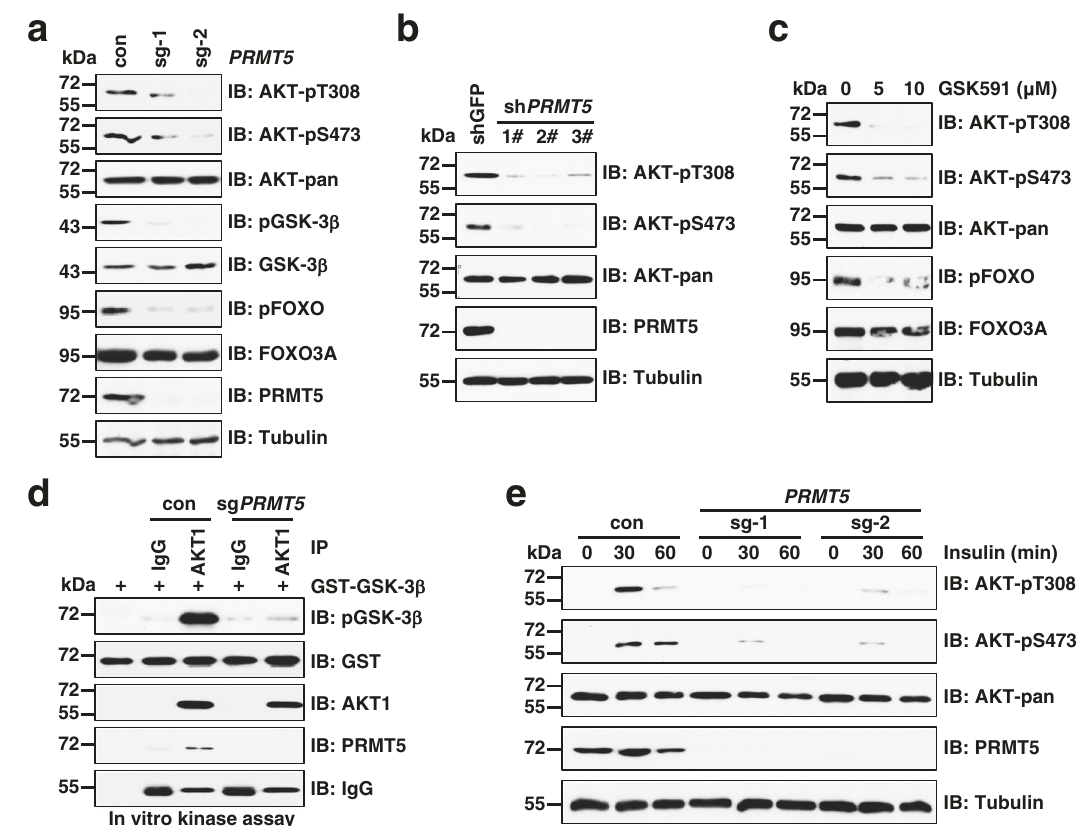
Fig. 1 De fi ciency in PRMT5 suppresses AKT activation. a , b Immunoblot (IB) analysis of whole cell lysates (WCLs) derived from MCF7 cells infected with lentiCRISPR virus ( a ) or shRNAs virus targeting PRMT5 ( b ). The cells were selected with 2 μ g/ml puromycin for 4 days to eliminate the non-infected cells. c IB analysis of WCLs derived from MCF7 cells treated with GSK591 for 24 h. d AKT in vitro kinase assays were performed using endogenous AKT1 (IgG as a negative control) immunopuri fi ed (IP) from control cells or sg PRMT5 cells as the kinase source and recombinant GST-GSK-3 β puri fi ed from bacteria as the substrate. e IB analysis of WCLs derived from control cells or PRMT5 -depleted MCF7 cells. Cells were serum-starved for 16 h and then treated with 100 nM insulin for 0, 30, and 60 min before collecting. Similar results were obtained in n ≥ 2 independent experiments in a – e . Uncropped immunoblots are provided in Source Data fi